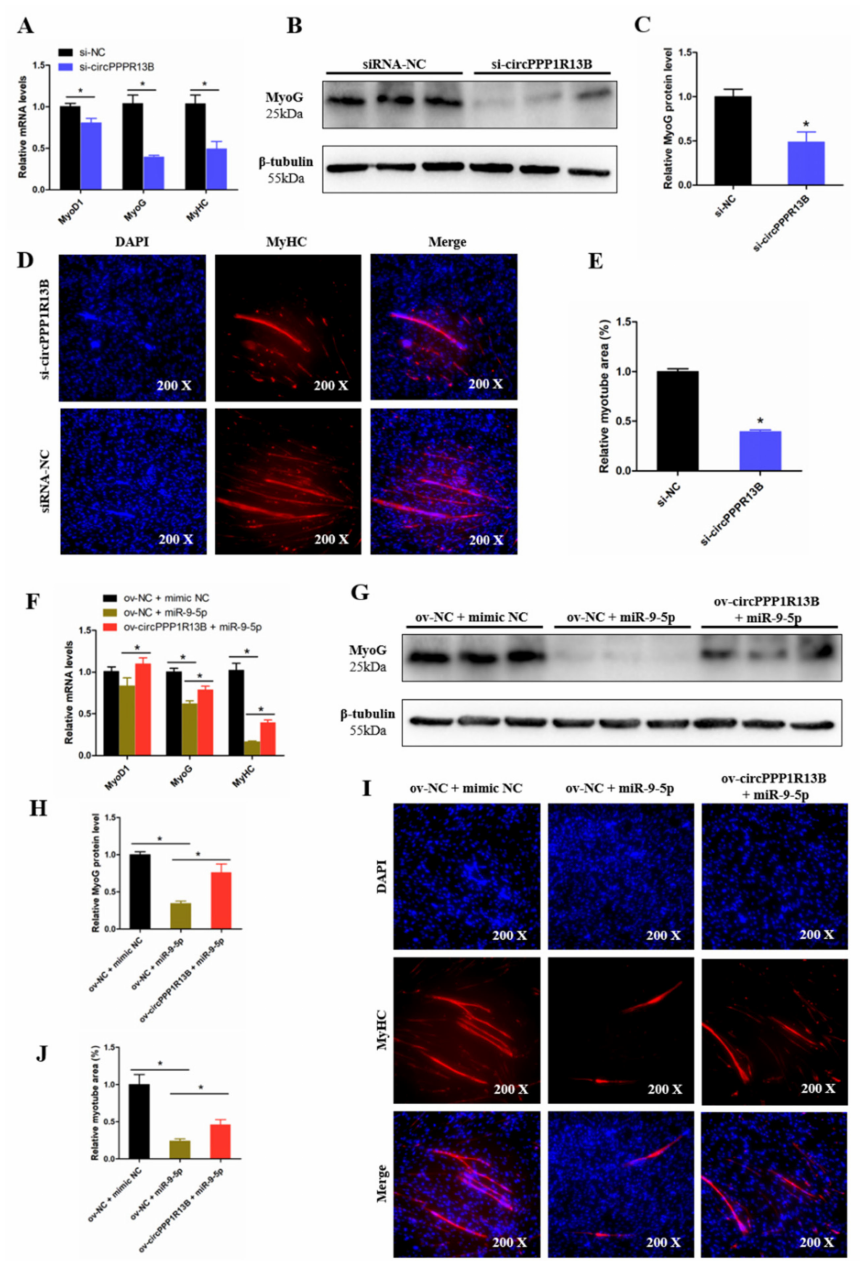
Figure 5. CircPPP1R13B regulates chicken SMSCs differentiation by targeting miR-9-5p. ( A ) Rel- ative expression of muscle cell differentiation marker genes following circPPP1R13B knockdown. ( B ) Protein level of MyoG and β -tubulin observed by western blot analysis. ( C ) Relative protein level of MyoG following circPPP1R13B knockdown. ( D ) Images of MyHC staining of SMSCs following circPPP1R13B knockdown. ( E ) Relative myotube area of SMSCs following circPPP1R13B knock- down. ( F ) Relative expression of muscle cell differentiation marker genes following circPPP1R13B co-overexpress circPPP1R13B with miR-9-5p. ( G ) Protein level of MyoG and β -tubulin observed by western blot analysis. ( H ) Relative protein level of MyoG following circPPP1R13B co-overexpress circPPP1R13B with miR-9-5p. ( I ) Images of MyHC staining of SMSCs following circPPP1R13B co-overexpress circPPP1R13B with miR-9-5p. ( J ) Relative myotube area of SMSCs following cir- cPPP1R13B co-overexpress circPPP1R13B with miR-9-5p. Asterisk indicate significant differences from the respective control (* p <